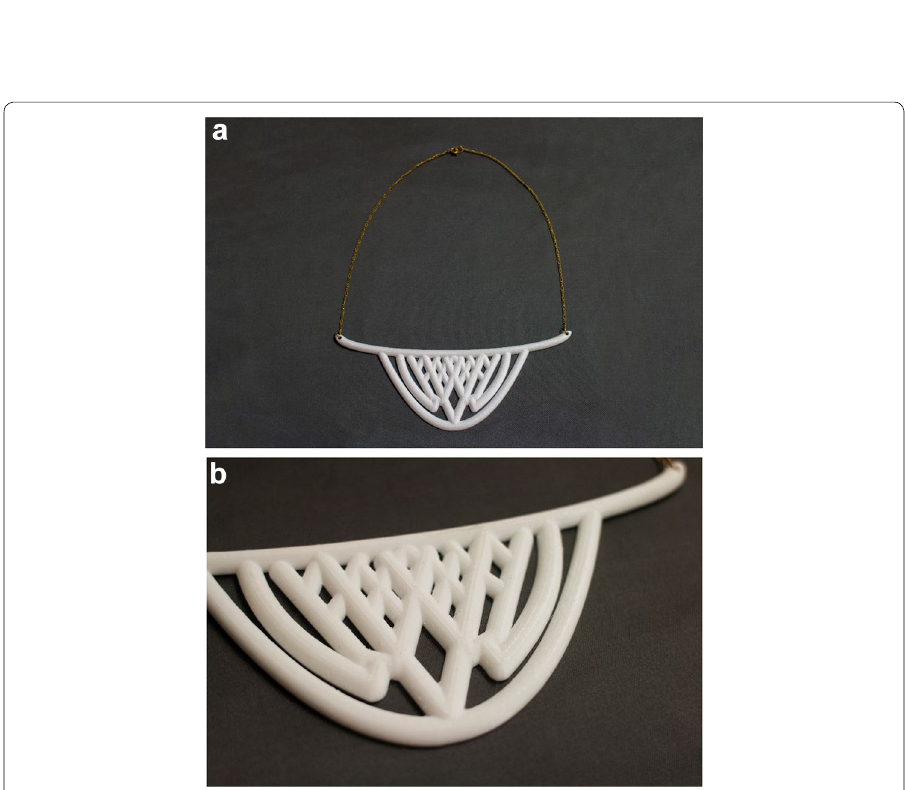
Fig. 6 a Jewelry pendant design 3 (white PLA filament). b Zoomed view of jewelry pendant design